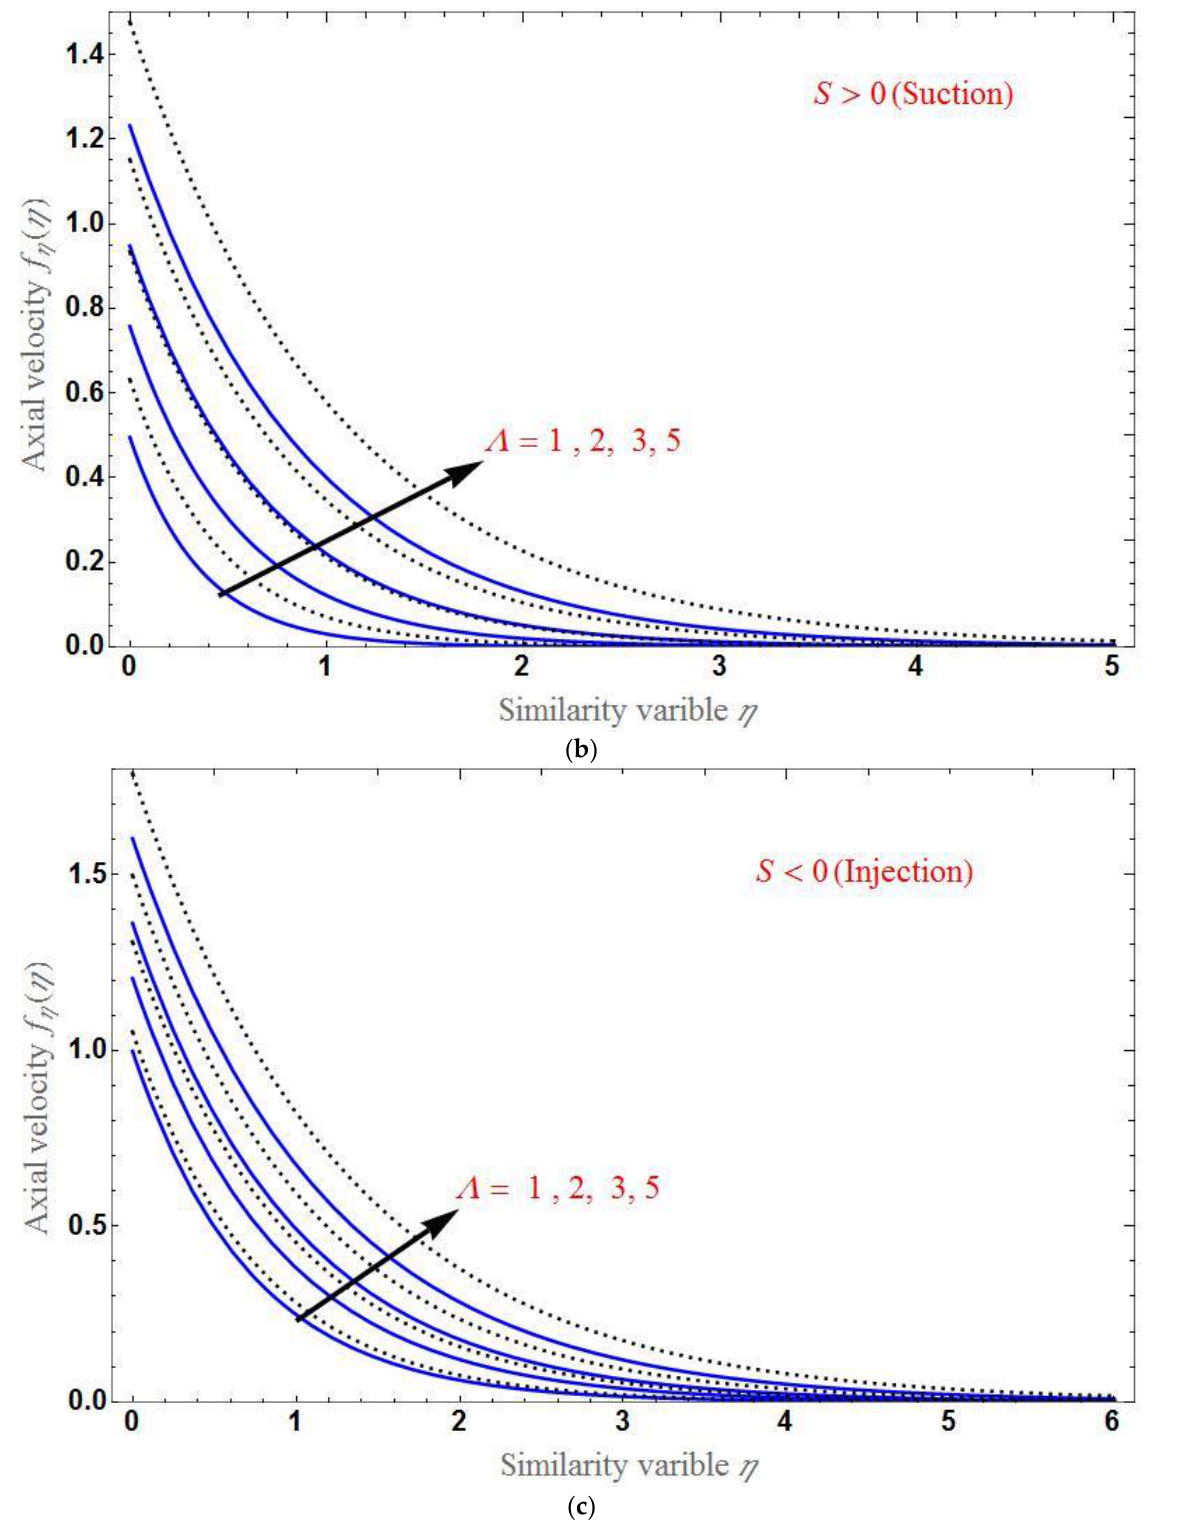
Figure 3. The axial velocity as a function of η for various values of Λ and for three different regimes of S : ( a ) S = 0, ( b ) S = 1 and ( c ) S = − 1. The other fixed parameters are: Da − 1 = M = 1, φ 1 = 0.1, φ 2 =